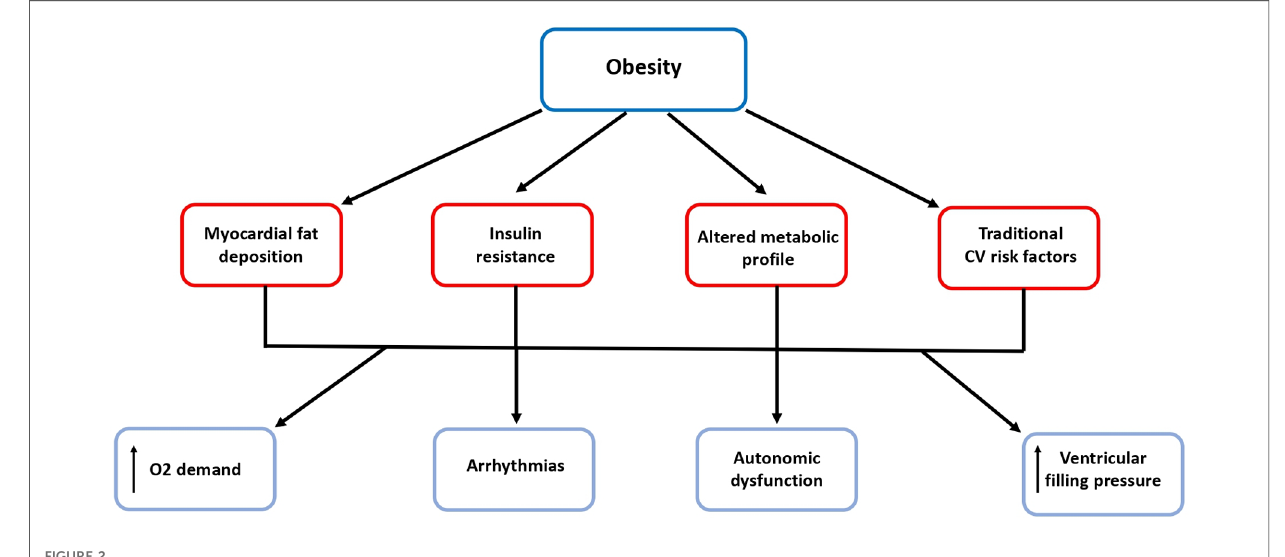
FIGURE 2 Obesity predisposes to arrhythmias and heart failure. Beside the relationship with traditional risk factors, obesity is associated with myocardial fat deposition, insulin resistance and altered metabolic pro fi le, which contribute to the development of atrial and ventricular remodeling, systolic and diastolic dysfunction and to increased ventricular fi lling pressures and fi nally to arrhythmias and overt HF. CV, cardiovascular; O2,